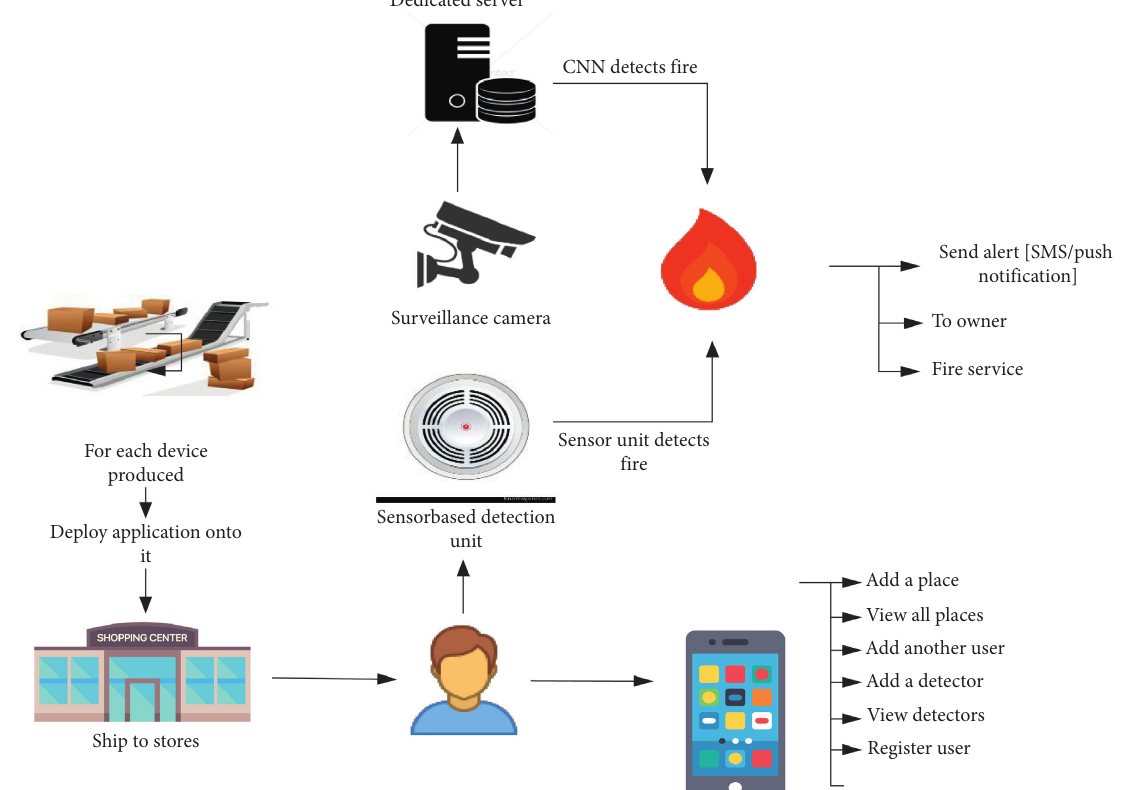
Figure 10: System architecture.